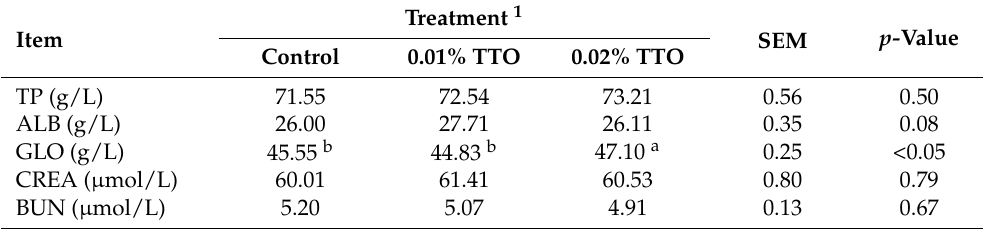
Table 4. Effects of TTO on serum-nitrogen-content-related indices of bovine in postpartum period.